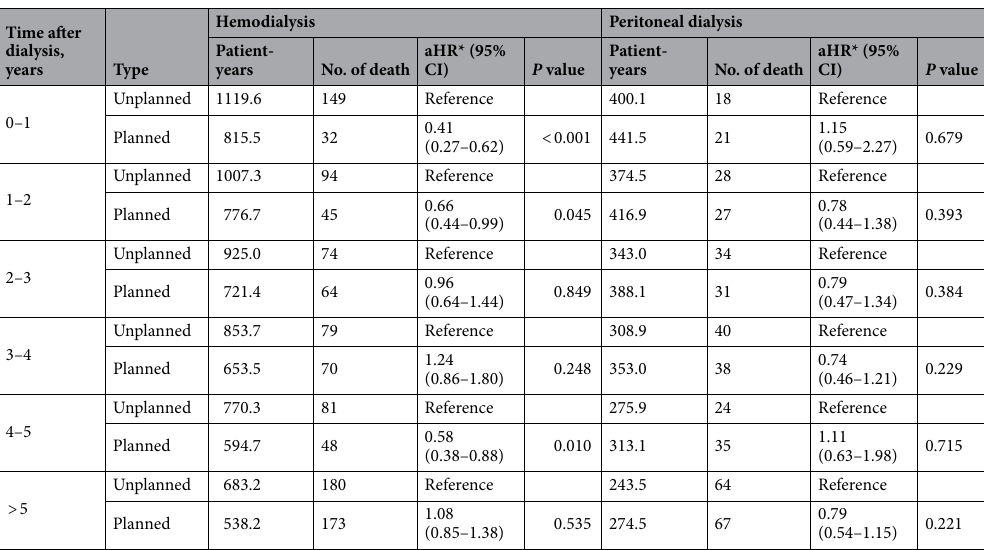
Table 3. Hazard ratios for annual mortality of planned dialysis by Cox proportional hazard model in hemodialysis and peritoneal dialysis. *Adjusted for age, sex, mCCI, serum hemoglobin, albumin, calcium, phosphate, 24-h urine volume, work status, insurance, marital status, and ambulation status. aHR adjusted hazard ratio, CI confidence interval, mCCI modified Charlson comorbidity index.